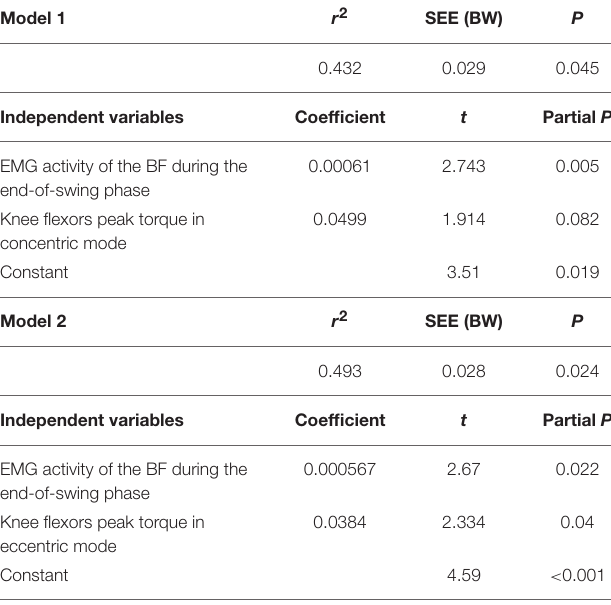
TABLE 3 | Multiple linear regression analysis for horizontal ground reaction force (in BW) averaged over the entire acceleration (dependent variable in both models), n = 14